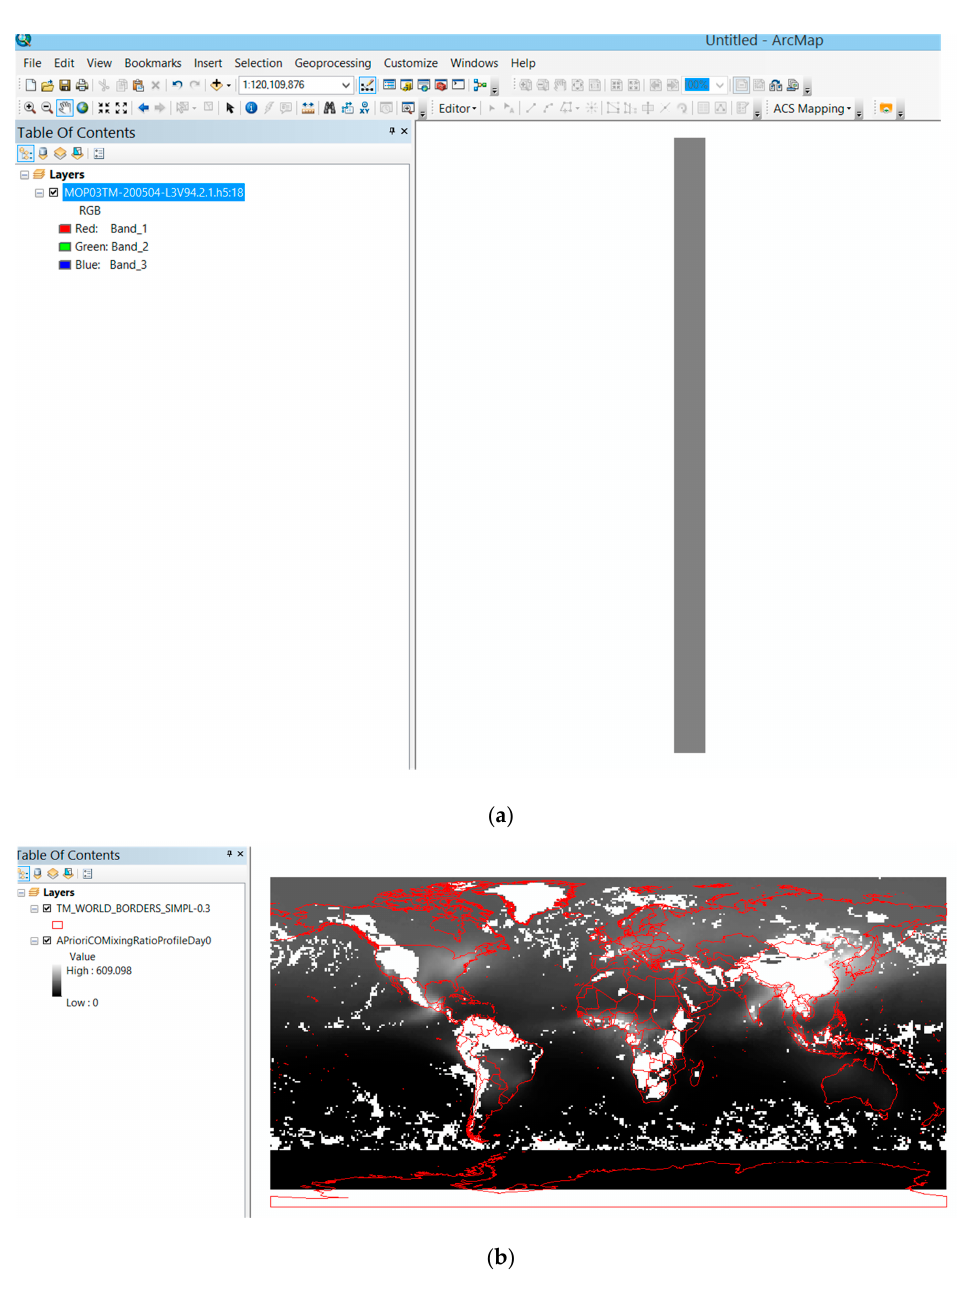
Figure 11. Three-dimensional EO data display in ArcGIS before ( a ) and after ( b ) using the enhanced GDAL .